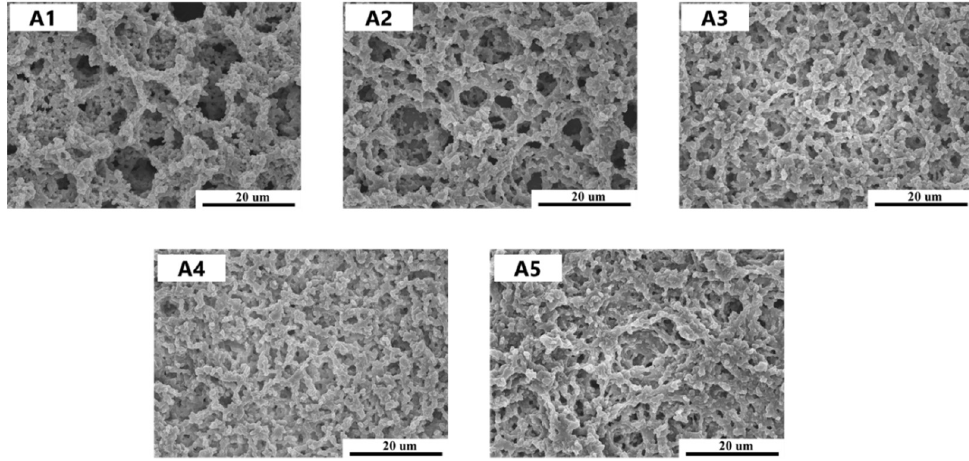
Figure 1. Microphotography of the morphology of PDLC films with different monomer contents: A1 (30%), A2 (35%), A3 (40%), A4 (45%), and A5 (50%).